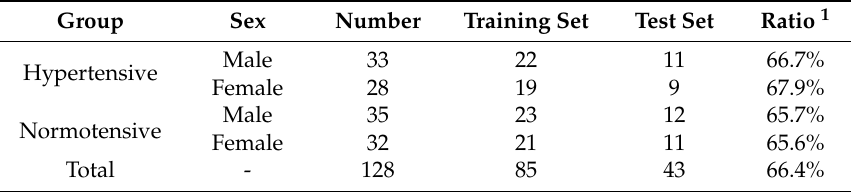
Table 3. The division of the experimental BCG